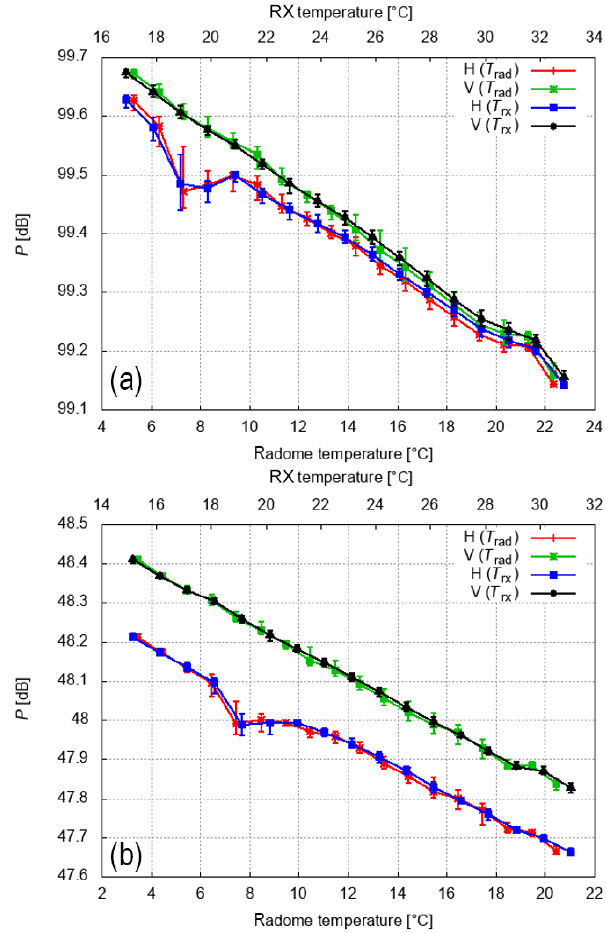
Figure 16. Bin-wise-averaged H and V power measurements based on the one-point calibration. Either the radome ( T rad ) or the receiver box temperature ( T rx ) is used as a reference. Shown is the median and the first and third quartiles of 1 ◦ wide temperature bins. The results with the TSG coupled to the LNA (a) and to the antenna cross-guide coupler (b) are